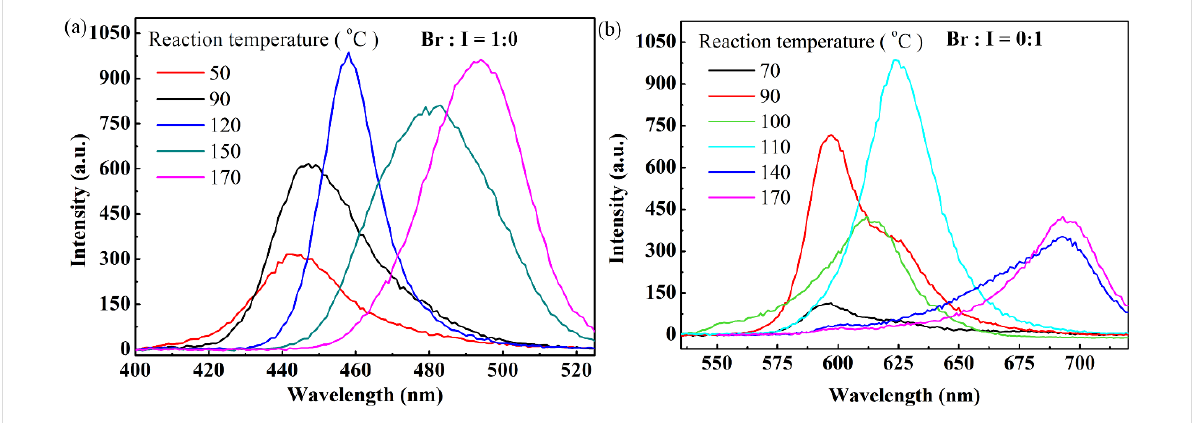
Figure 4: Photoluminescence spectra of CsPbX 3 quantum dots prepared at different reaction temperatures: (a) X = Br, and (b) X = I.